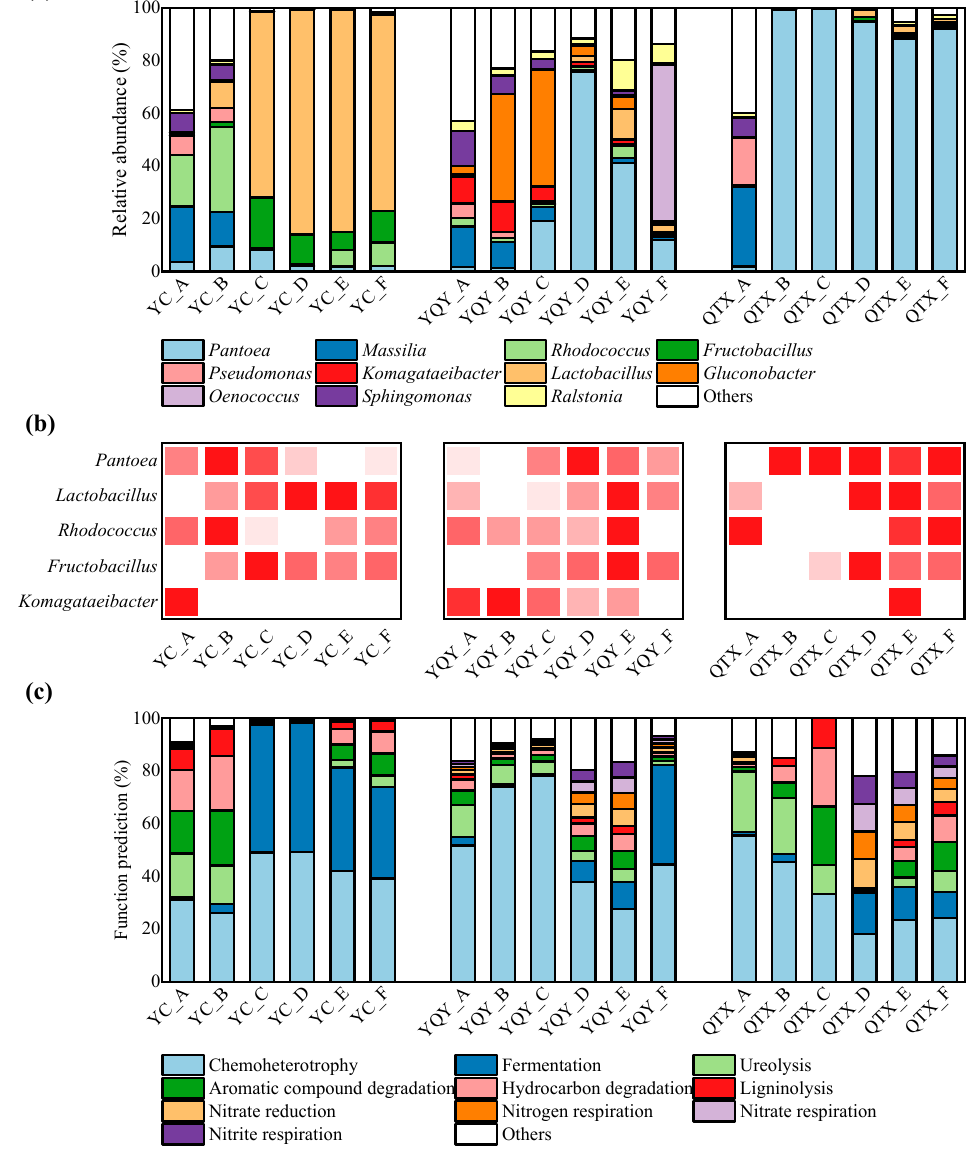
Figure 5. Bacterial communities and their functional annotation in different fermentation stages. The successions of bacteria at genus level during fermentation: ( a ) top 11 genera with relative abundance greater than 0.1%, and ( b ) 5 core genera (darker red squares represent higher relative abundance); ( c ) top 10 functions annotated by the FAPROTAX database.